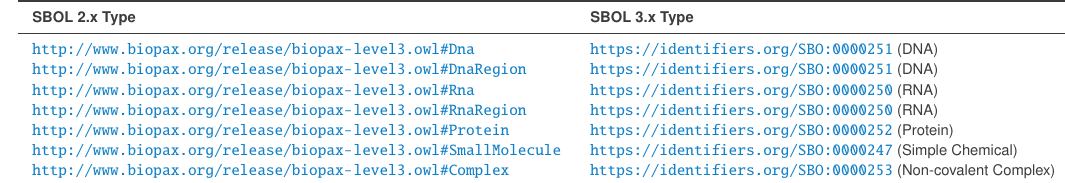
Table 19: Mapping of SBOL2 ComponentDefinition types to SBOL3 Component types